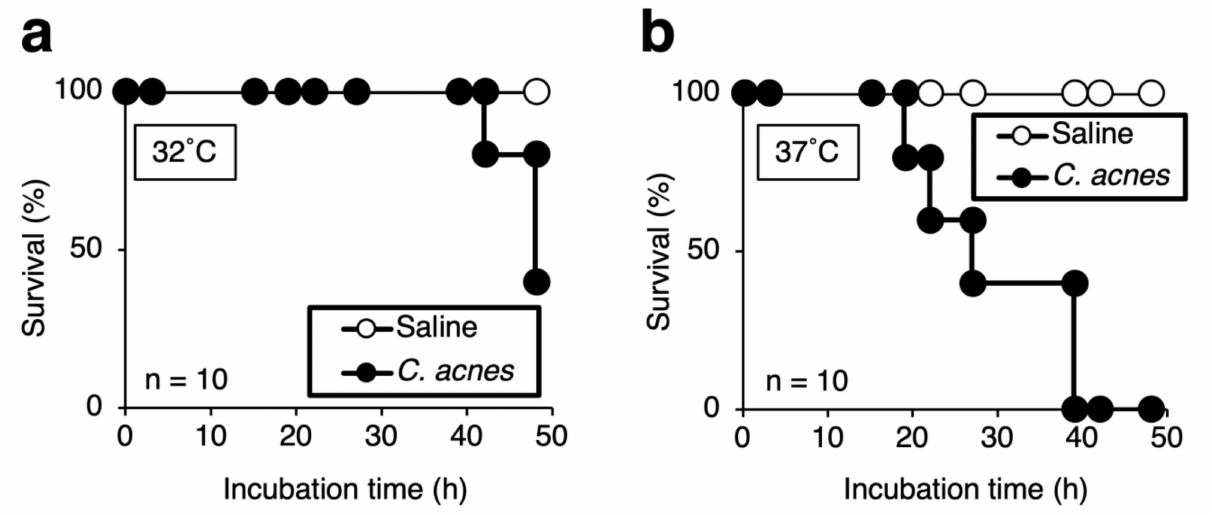
Figure 1. Toxic effects of C. acnes injected into silkworms. Silkworms were injected with saline (50 µ L) or C. acnes cell suspension (1.6 × 10 9 cells/50 µ L) and incubated at 32 ◦ C ( a ) and 37 ◦ C ( b ). The number of surviving silkworms was measured for 48 h. n = 10/group.